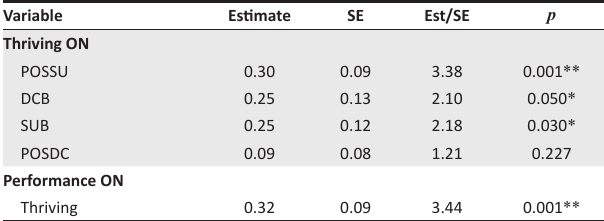
TABLE 3: Standardised regression coefficients.